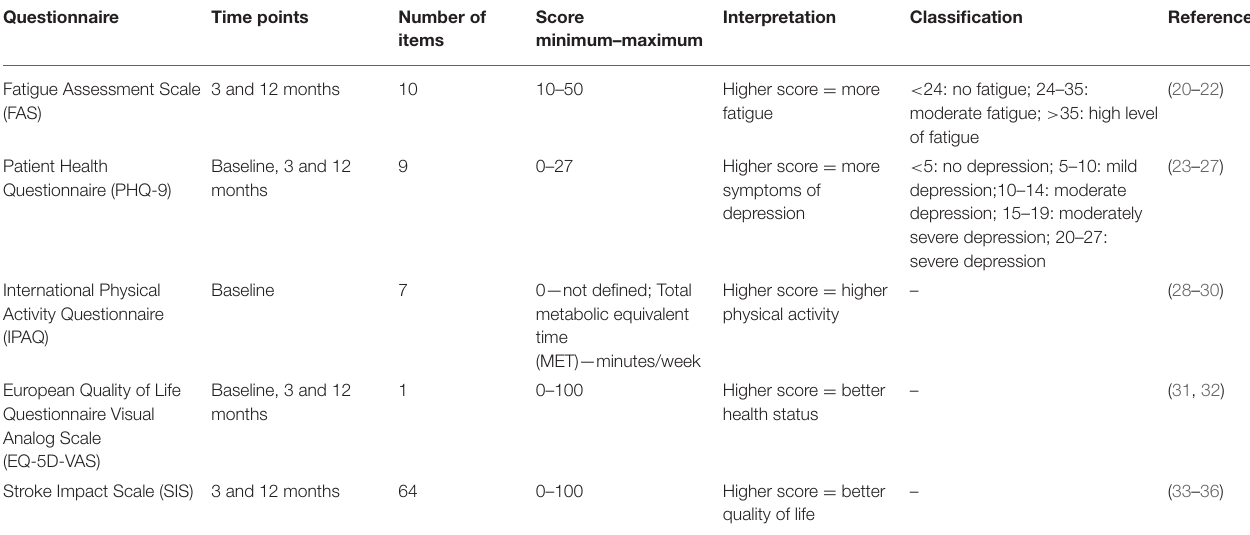
TABLE 1 | Summary of the standardized questionnaires used in the